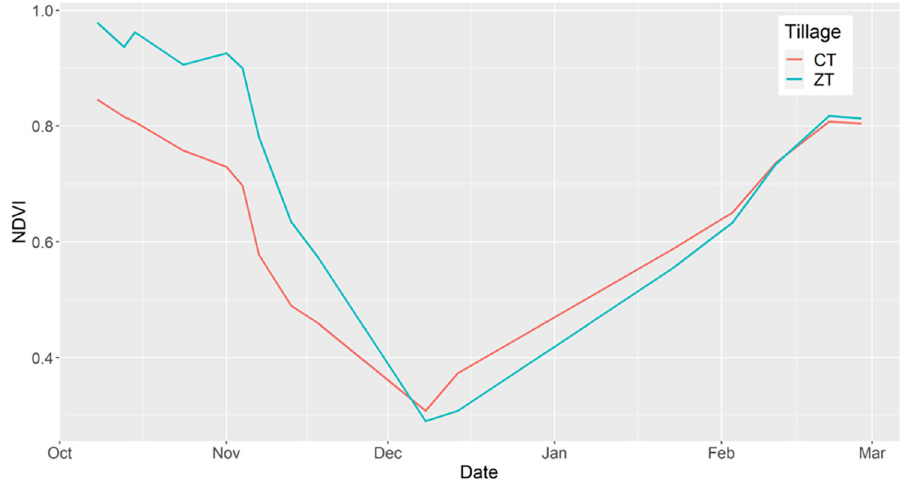
Fig 3. Phenology curves generated from averaged NDVI values of all ZT (red) and CT (blue) fields for the 2017– 18 growing season using Sentinel-2 imagery. The drop in NDVI values from October to December represents the end of the rice crop, and captures senescence, harvest, and the removal of residues. The increase in NDVI values from December until March represents wheat biomass growth after planting.